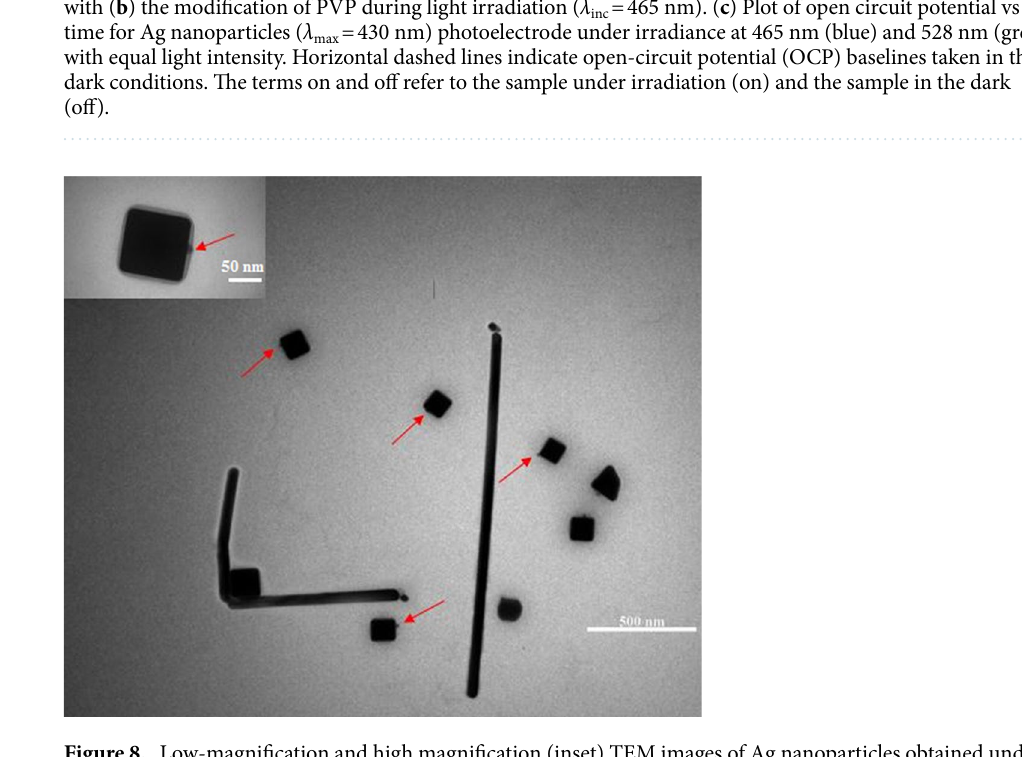
Figure 8. Low-magnification and high magnification (inset) TEM images of Ag nanoparticles obtained under irradiance with LED source at 528 nm after 90 min. Red arrows show that silver is deposited randomly on all